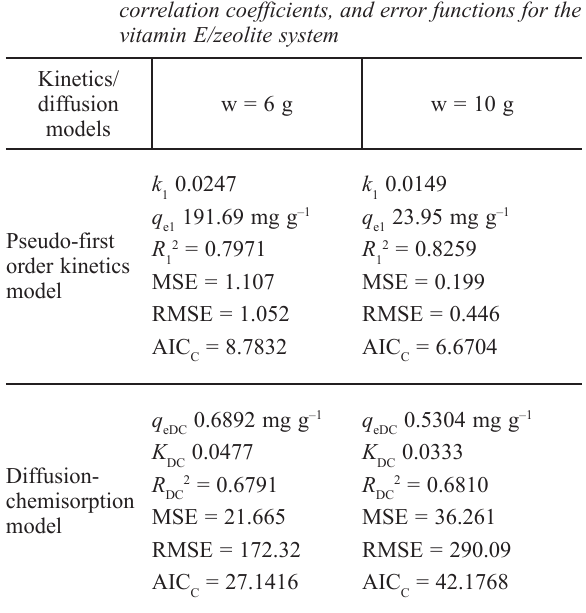
Table 3 – Values of the kinetics and diffusion parameters, correlation coefficients, and error functions for the vitamin E/zeolite